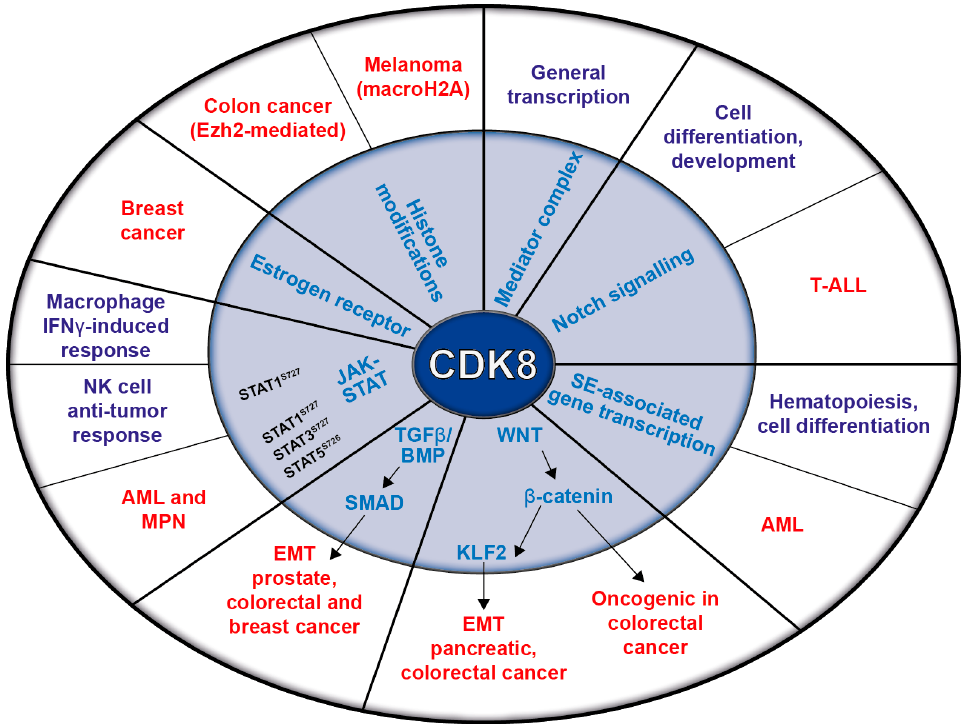
Figure 2. Schematic representation of CDK8’s functions in transcription and signaling pathways (inner circle) and their relation to physiological (violet) and pathological (red) conditions (outer